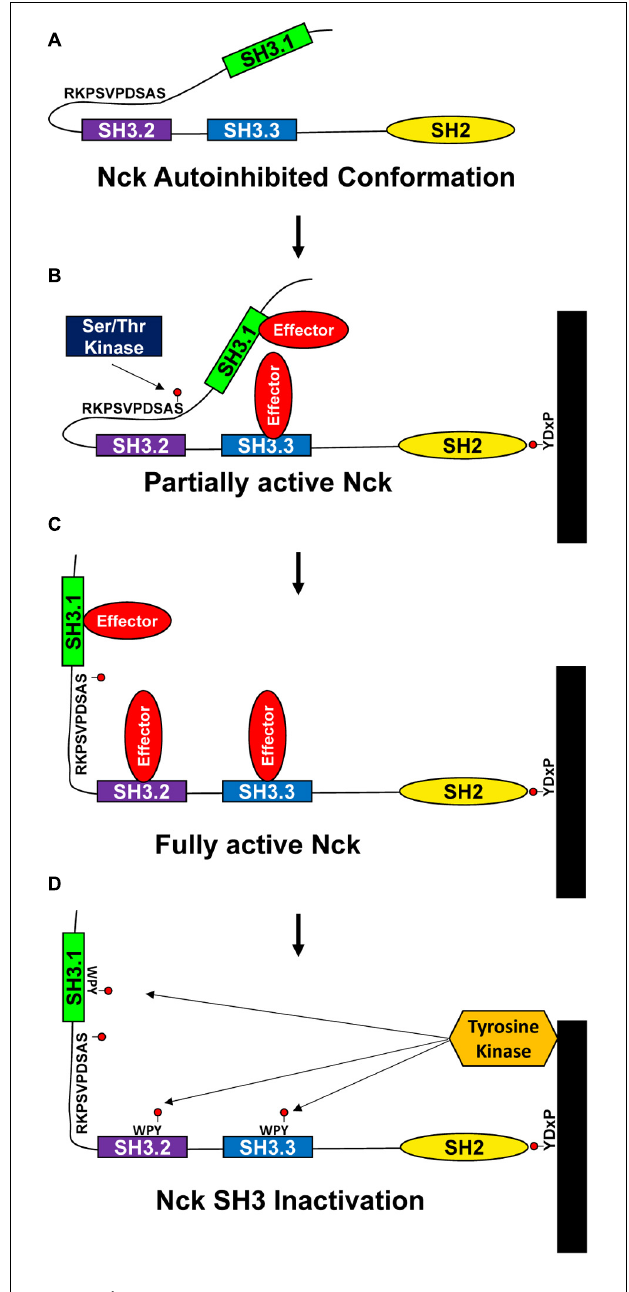
FIGURE 2 | Proposed model for Nck1/2 regulation. (A) Intramolecular interactions between the Nck1/2 SH3.2 domain and a peptide in the linker between the SH3.1 and SH3.2 domains may limit SH3.2 interactions with other targets. (B,C) Phosphorylation of Ser85 in response to cell stimulation may reduce this intramolecular interaction to activate Nck1/2, allowing recruitment of effector proteins. (D) Tyrosine phosphorylation within the WPY motifs in the SH3 domains may limit SH3 domain interactions to inactivate